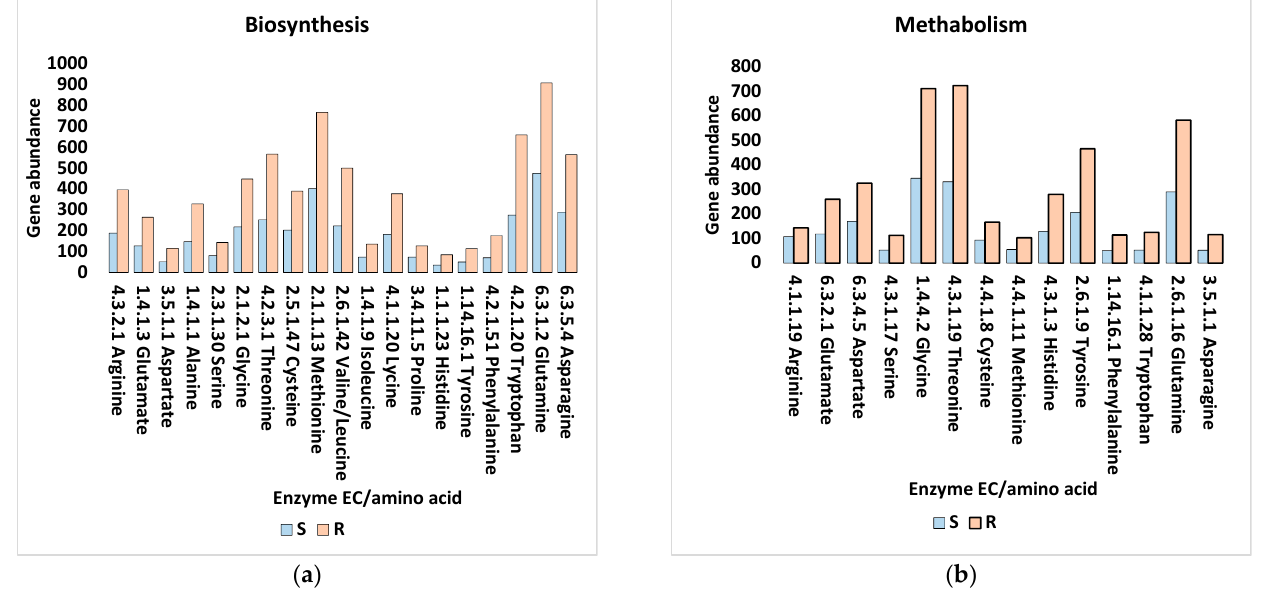
Figure 5. Abundance of genes encoding selected highly enriched enzymes in KEGG pathways towards either the biosynthesis ( a ) or metabolism ( b ) of amino acids in the rhizobiome of M. oleifera . Detailed information regarding the abundance of genes encoding these and other enzymes in different KEGG pathways is shown in Table S11. Detailed descriptions of these enzyme ECs are given in Table S4. There are several other enzymes that participate in either process and follow the same pattern of gene abundance and enzyme enrichment.